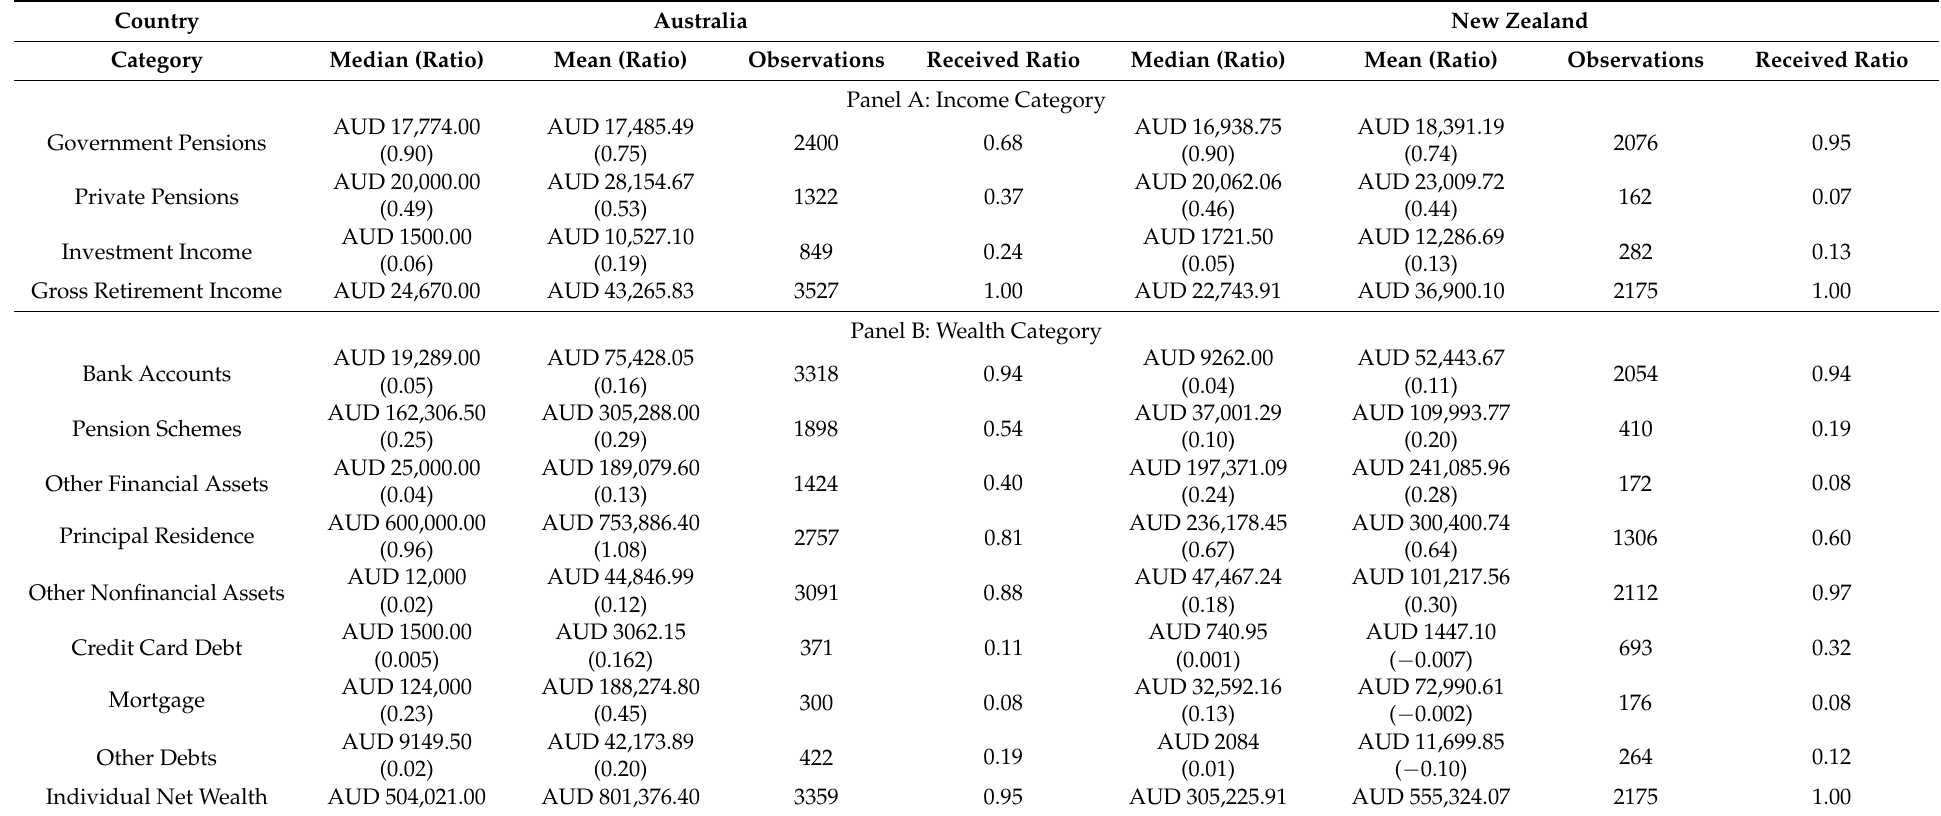
Table 2. Individual financial year income and wealth comparisons for ageing populations in 2018, in Australian